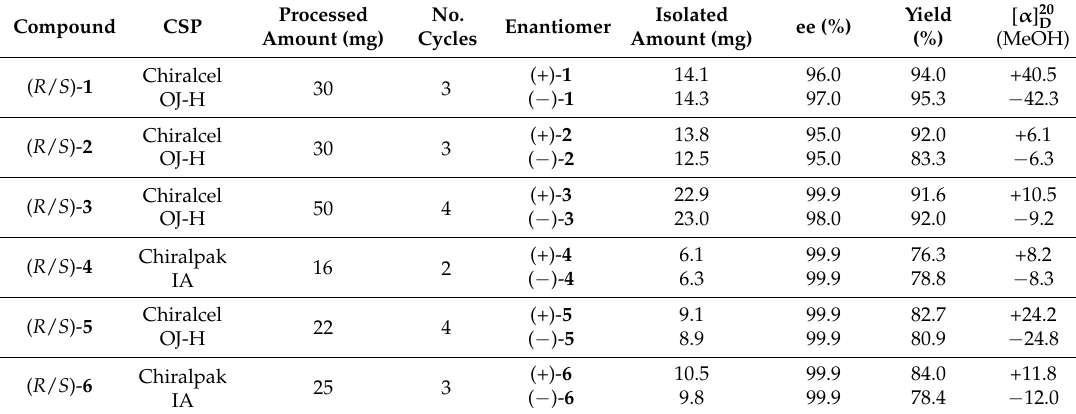
Table 6. (Semi-)preparative resolution of ( R / S )- 1 , ( R / S )- 2 , ( R / S )- 3 , ( R / S )- 5 on Chiralcel OJ-H (10 mm × 250 mm, dp = 5 µ m) and of ( R / S )- 4 and ( R / S )- 6 on Chiralpak IA (10 mm × 250 mm, dp = 5 µ m).